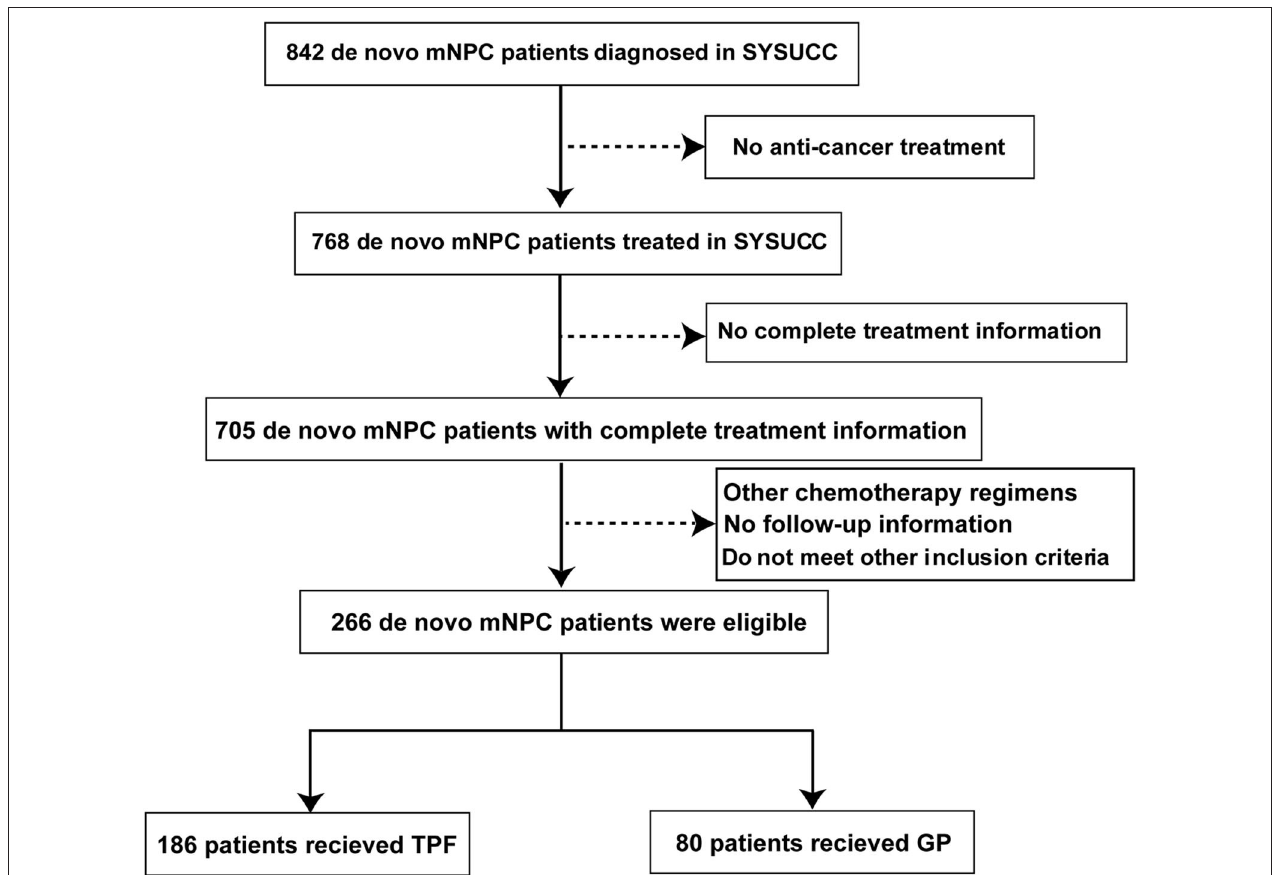
FIGURE 1 | Flowchart of study patient inclusion. mNPC, metastatic nasopharyngeal carcinoma; GP, gemcitabine plus cisplatin; TPF, docetaxel plus fluorouracil plus cisplatin.